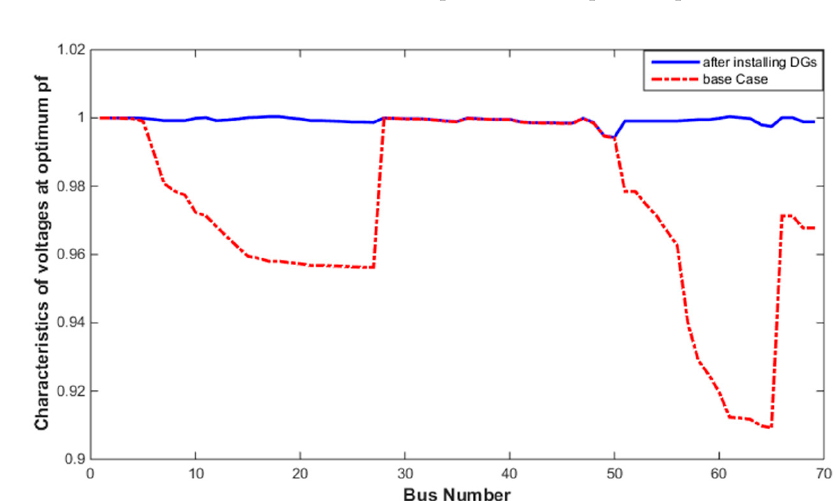
Figure 30. Characteristics of voltage at optimum pf.